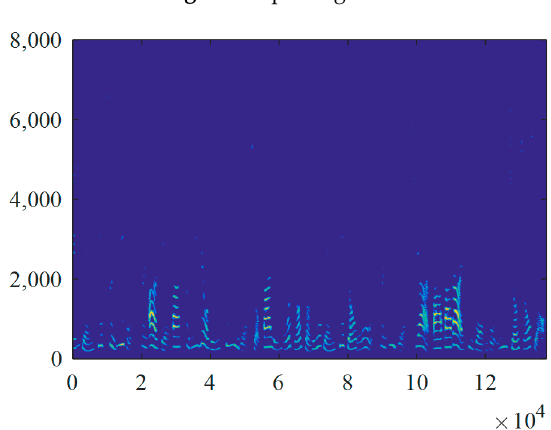
Figure 4. Spectrogram.